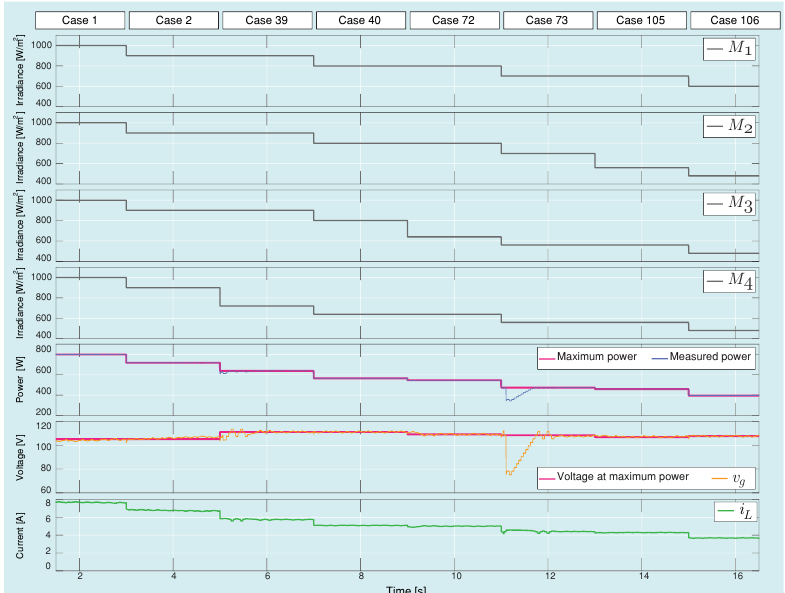
Figure 19. High-resolution simulation of the proposed ABC-P&O MPPT algorithm for Scenario 7. The selected cases, presented in Figure 2, ensured gradual changes in irradiance and shading pattern at each of the four PV KC200GT modules ( M 1 to M 4 ) connected in